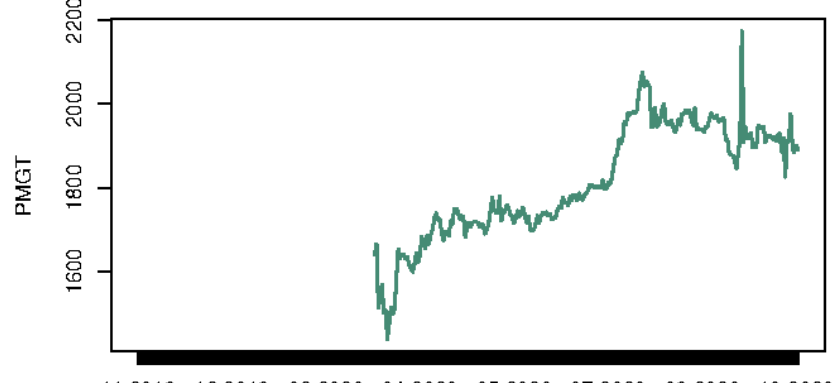
Figure 7. Price of PAX Gold (PAXG)—CoinMarketCap. Last but not least, we visualize the evolution of the two latest gold-backed tokens, Perth Mint (Figure 8) and Tether Gold (Figure 9), whose evolution is ever-increasing during the pandemic period. Similar comments to Digix therefore apply.